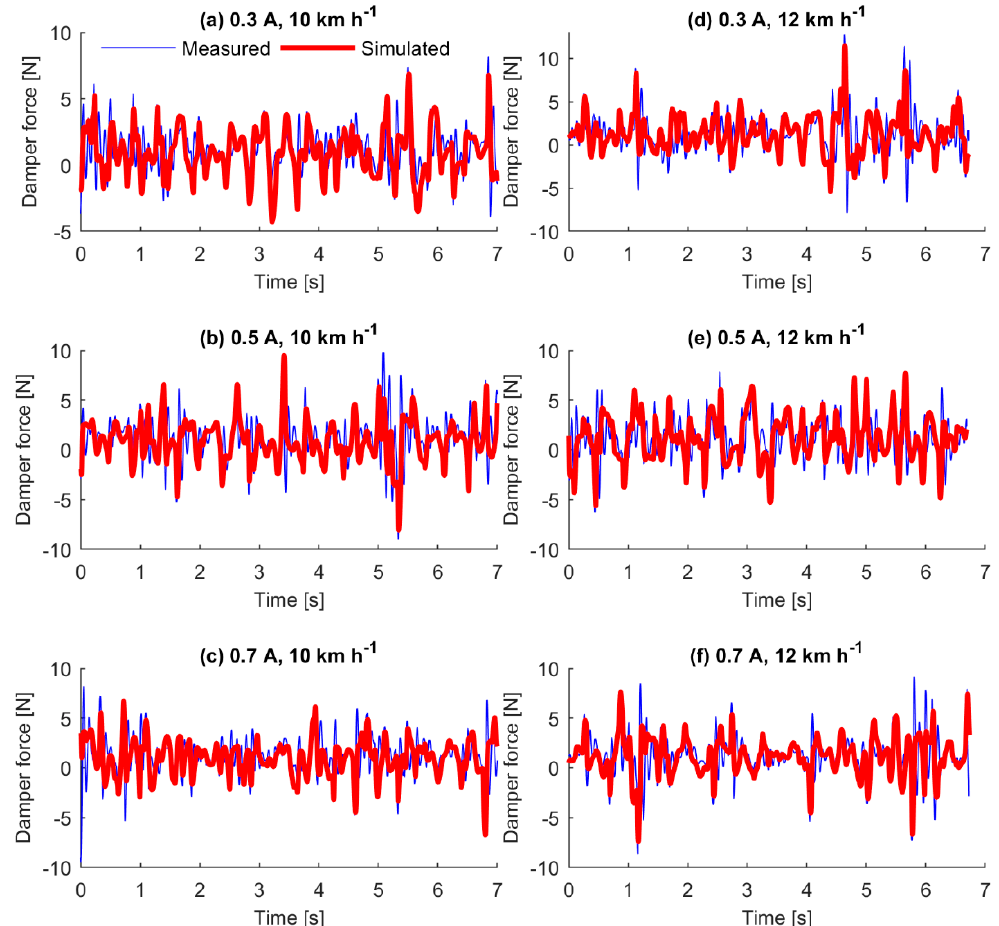
Figure 7. The measured and simulated damper forces resulted from the MR damper at the speed of ( a – c ) 10 km h − 1 and ( d – f ) 12 km h − 1 , when the MR damper was supplied with 0.3 A, 0.5 A, and 0.7 A.